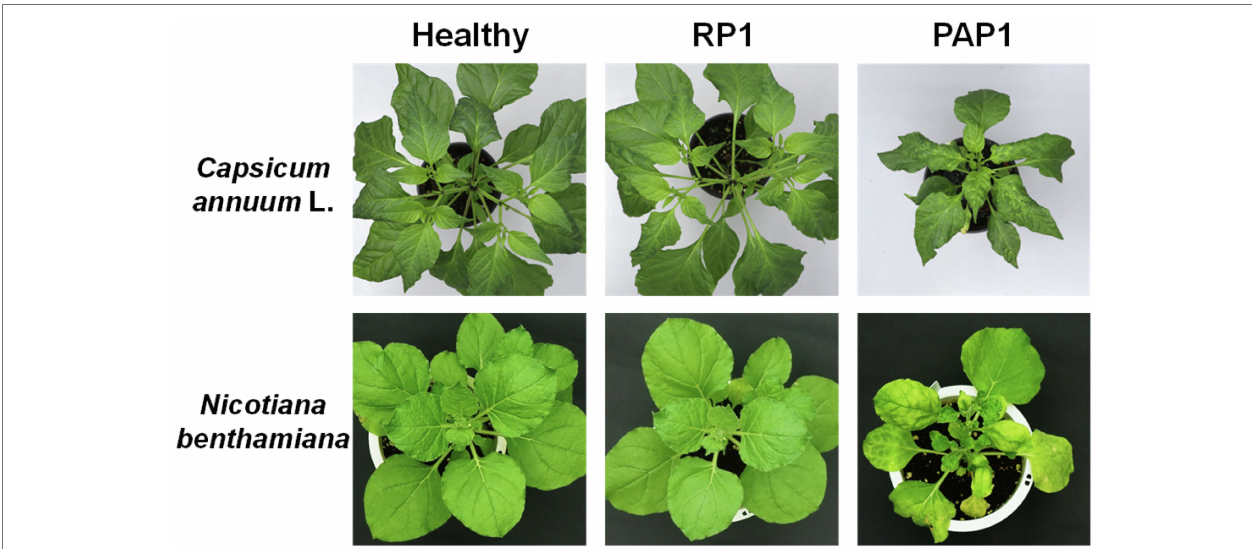
FIGURE 1 | Symptomatic responses of pepper ( Capsicum annuum L.) and Nicotiana benthamiana plants upon infection with BBWW2 isolates PAP1 or RP1. BBWV2-RP1 induced no visible symptoms in pepper and very mild symptoms in N. benthamiana , whereas BBWV2-PAP1 caused severe disease symptoms in pepper and N. benthamiana